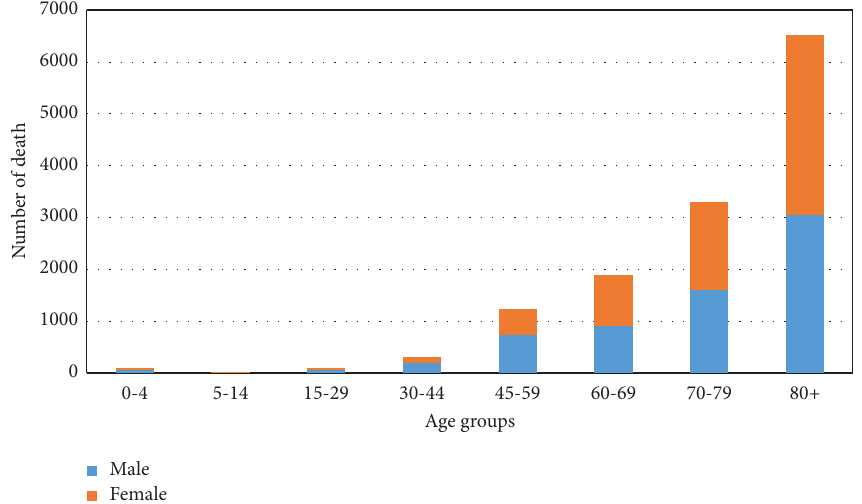
Figure 1: Number of deaths due to hypertension based on gender and age groups.